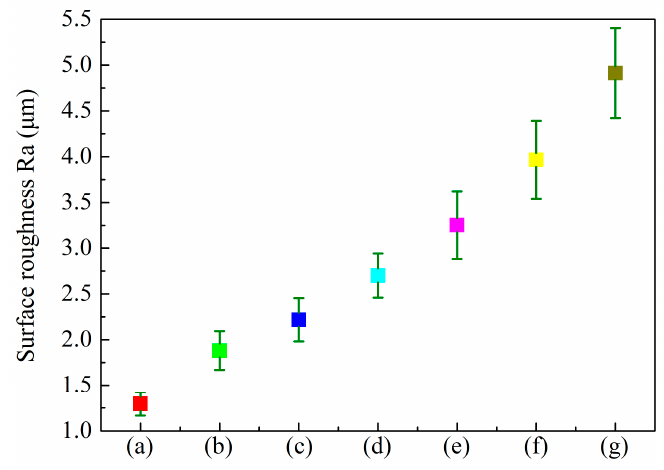
Figure 4. The surface roughness of microarc oxidation coatings formed on aluminum alloys at different anode pulse-widths. (a): 1000 µ s; (b): 1500 µ s; (c): 2000 µ s; (d): 2500 µ s; (e): 3000 µ s; (f): 3500 µ s; (g): 4000 µ s.